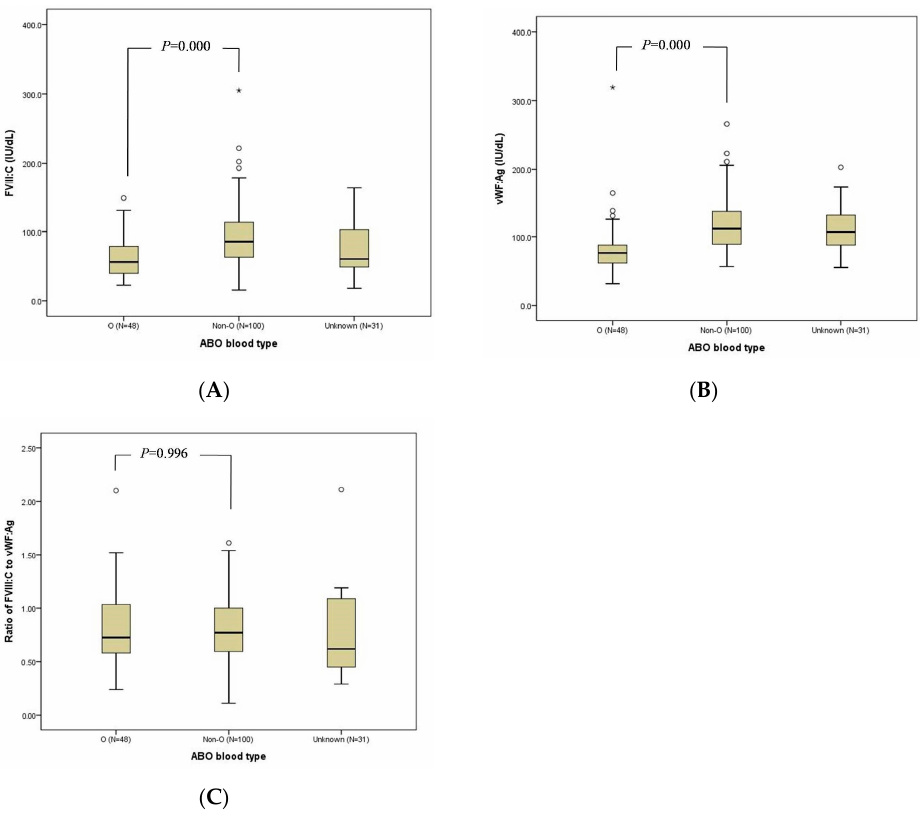
Figure 1. FVIII:C ( A ), VWF:Ag ( B ), and FVIII:C/VWF:Ag ratio ( C ) between O and non-O blood type.